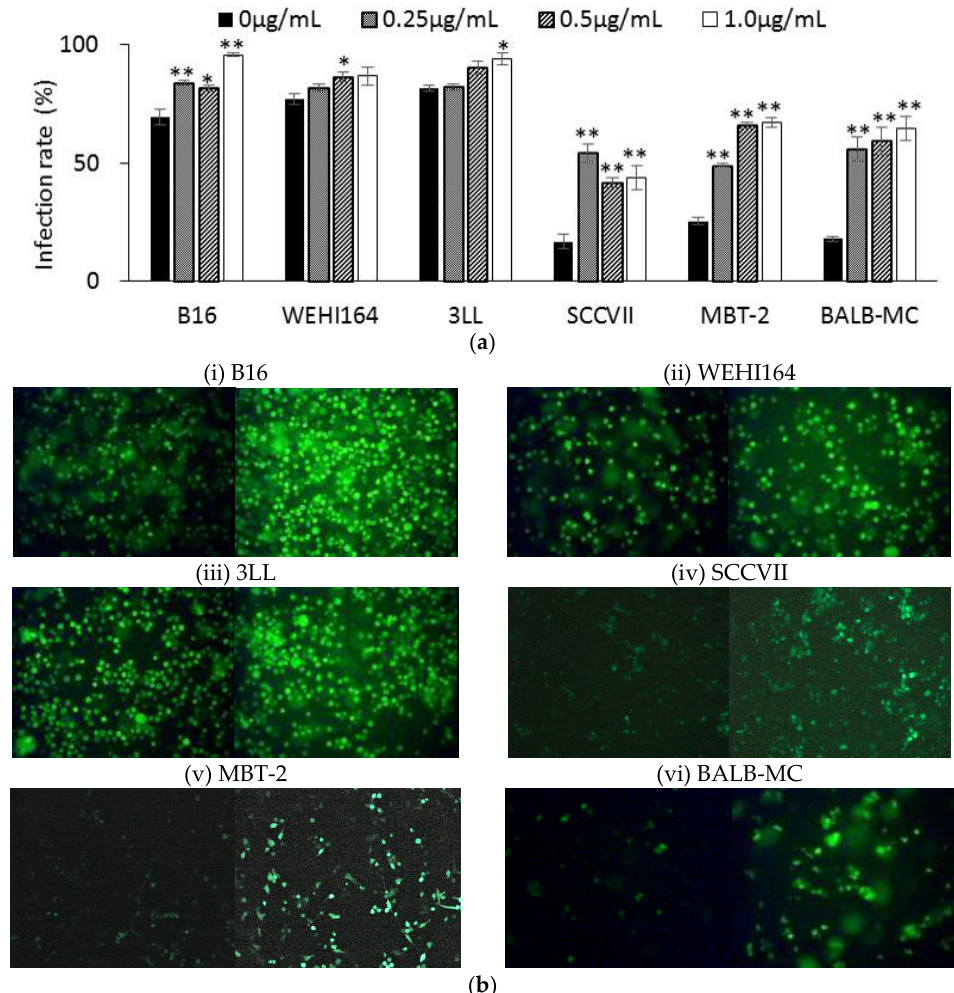
Figure 3. rNDV infection rate in tumor cells after ruxolitinib treatment. ( a ) Tumor cells were infected with rNDV (MOI of 2) after ruxolitinib (0~1.0 μg/mL) treatment for 20 h. The infection rate was calculated from the GFP expressing cell ratio observed via fluorescent microscopy (* p < 0.05, ** p < 0.01).